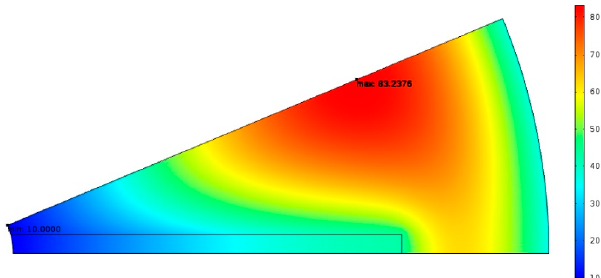
Figure 7. Temperature distribution of the eight-fin reactor for the case of convection at 60 s (temperature in °C).